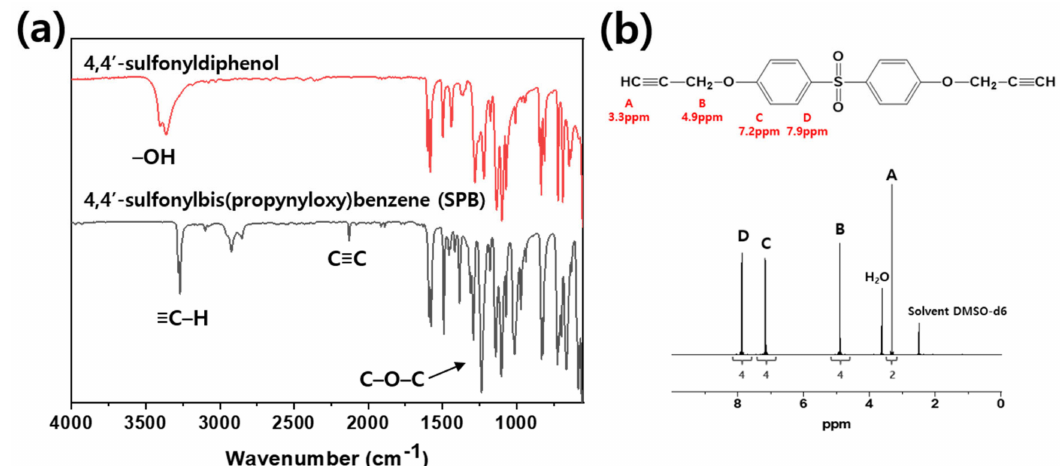
Figure 5. ( a ) FT-IR and ( b ) 1 H-NMR spectrum of